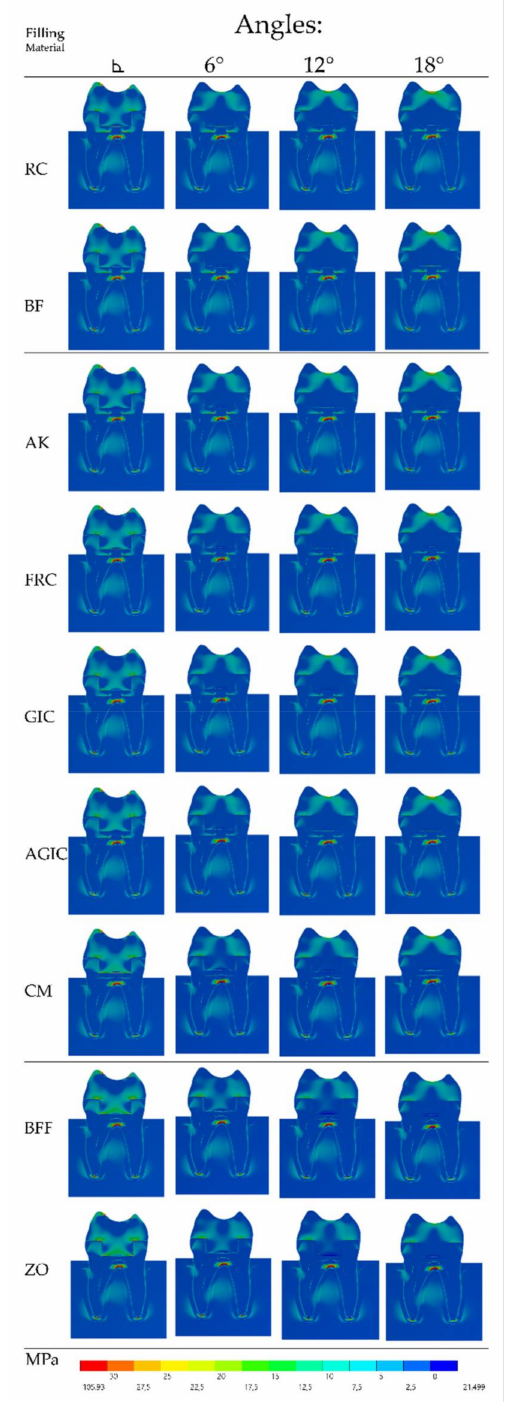
Figure 3. Tensile stress distribution in the endocrown section plane according to the pulp chamber axial walls angle (columns) and restorative material (rows). The corresponding filling materials are: resin composite, bulk-fill resin composite, alkasite, flowable resin composite, glass ionomer cement, autocured resin-reinforced glass ionomer cement, resin cement, bulk-fill flowable resin composite, and zinc oxide